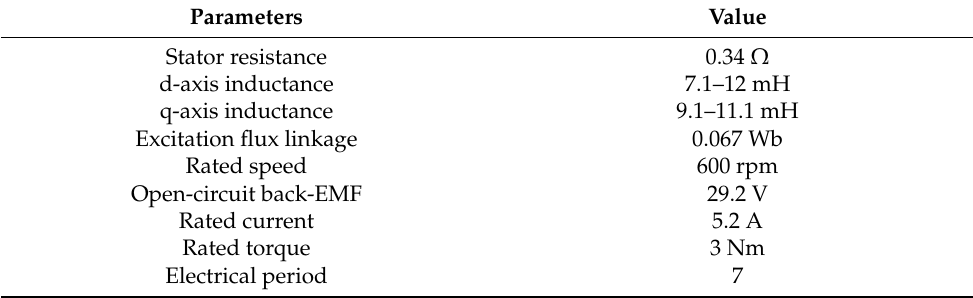
Table 2. Main Electromagnetic Parameters of the Proposed Machine.